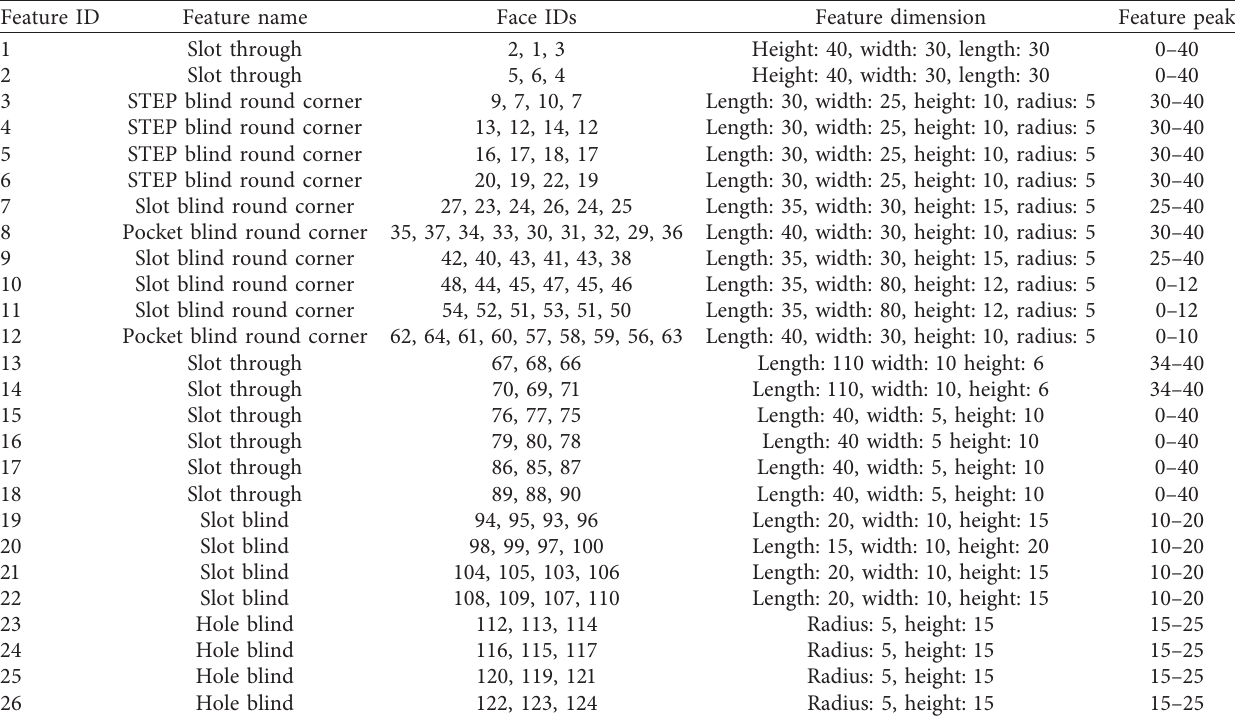
Figure 11: Test part (solid body) with feature IDs. Table 6: Feature extraction and